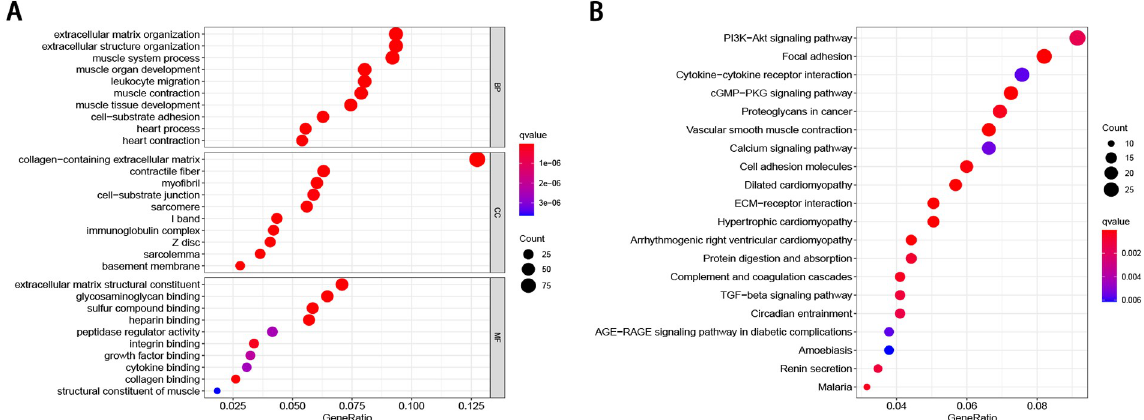
Fig 8. Functional enrichment analysis of the differentially expressed genes (A) Top 10 GO-enriched differentially expressed genes (B) Top 20 enriched KEGG pathways of the differentially expressed genes.